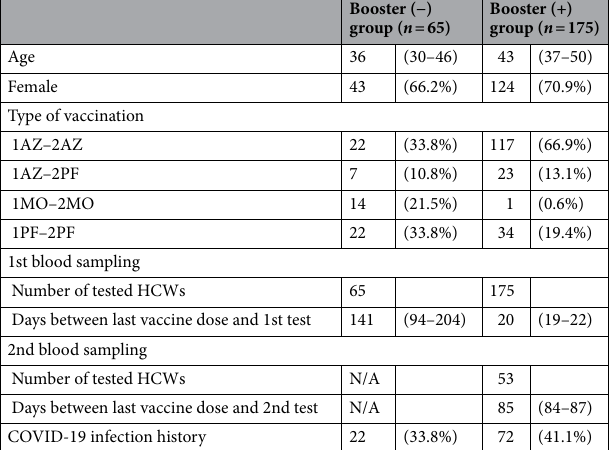
Table 1. Basic characteristics of enrolled healthcare workers (HCWs). Data are shown as median with interquartile range or number with percentage. AZ AstraZeneca COVID-19 Vaccine, MO Moderna COVID-19 Vaccine, N/A not applicable, PF Pfizer-BioNTech COVID-19